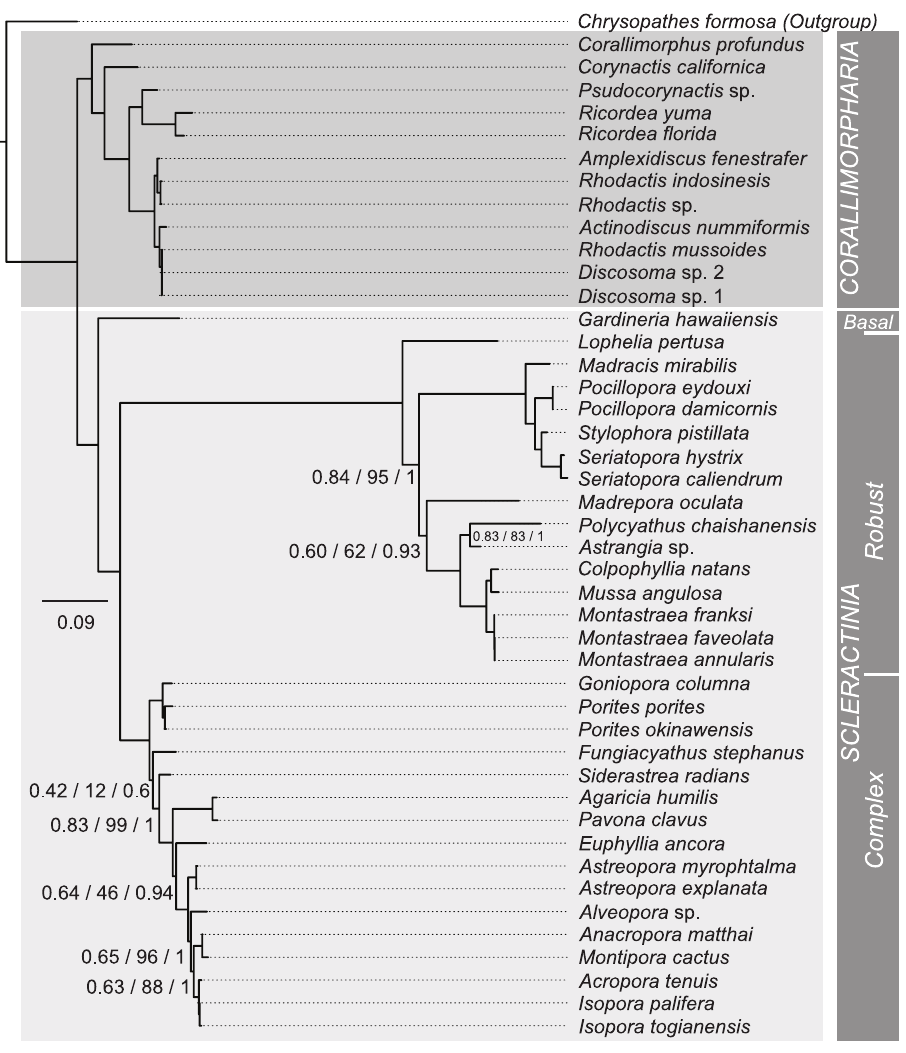
Figure 5. Phylogenetic analyses of the mitochondrial sequences encoding stable RNAs (12S rRNA, 16S rRNA, trnM , and trnW ). Values on the nodes indicate the non-parametric SH test and bootstrap replicates (ML), and posterior probability (BI) support respectively. Where no values are shown on a node, that edge was fully supported under all analyses. Large boxes indicate the Corallimorpharia (dark-gray) and Scleractinia (light- gray) clades. Note that deep-water azooxanthellate species ( Corallimorphus profundus and Gardineria hawaiiensis ) represent the earliest diverging branches for Corallimorpharia and Scleractinia respectively.